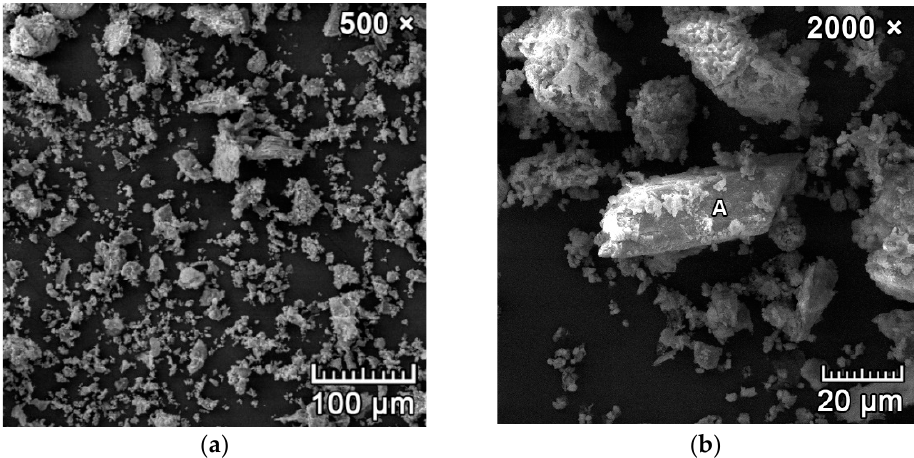
Figure 2. SEM microphotographs of used CCFA; ( a ) overall microstructure of particles; ( b ) detail of anhydrite crystal (marked as A) surrounded by clusters of smaller quartz, calcite, and amorphous particles. The granulometry of CCFA-H according to the residue on a screen (63 µ m size) was determined, and the resulting 28.6% is conventional for this type of fly ash. Used CCFA was not treated (milled) for the experiment. However, according to [6], the granulometry of CCFAs influenced the temperature of the SO 2 content in the flue-gas